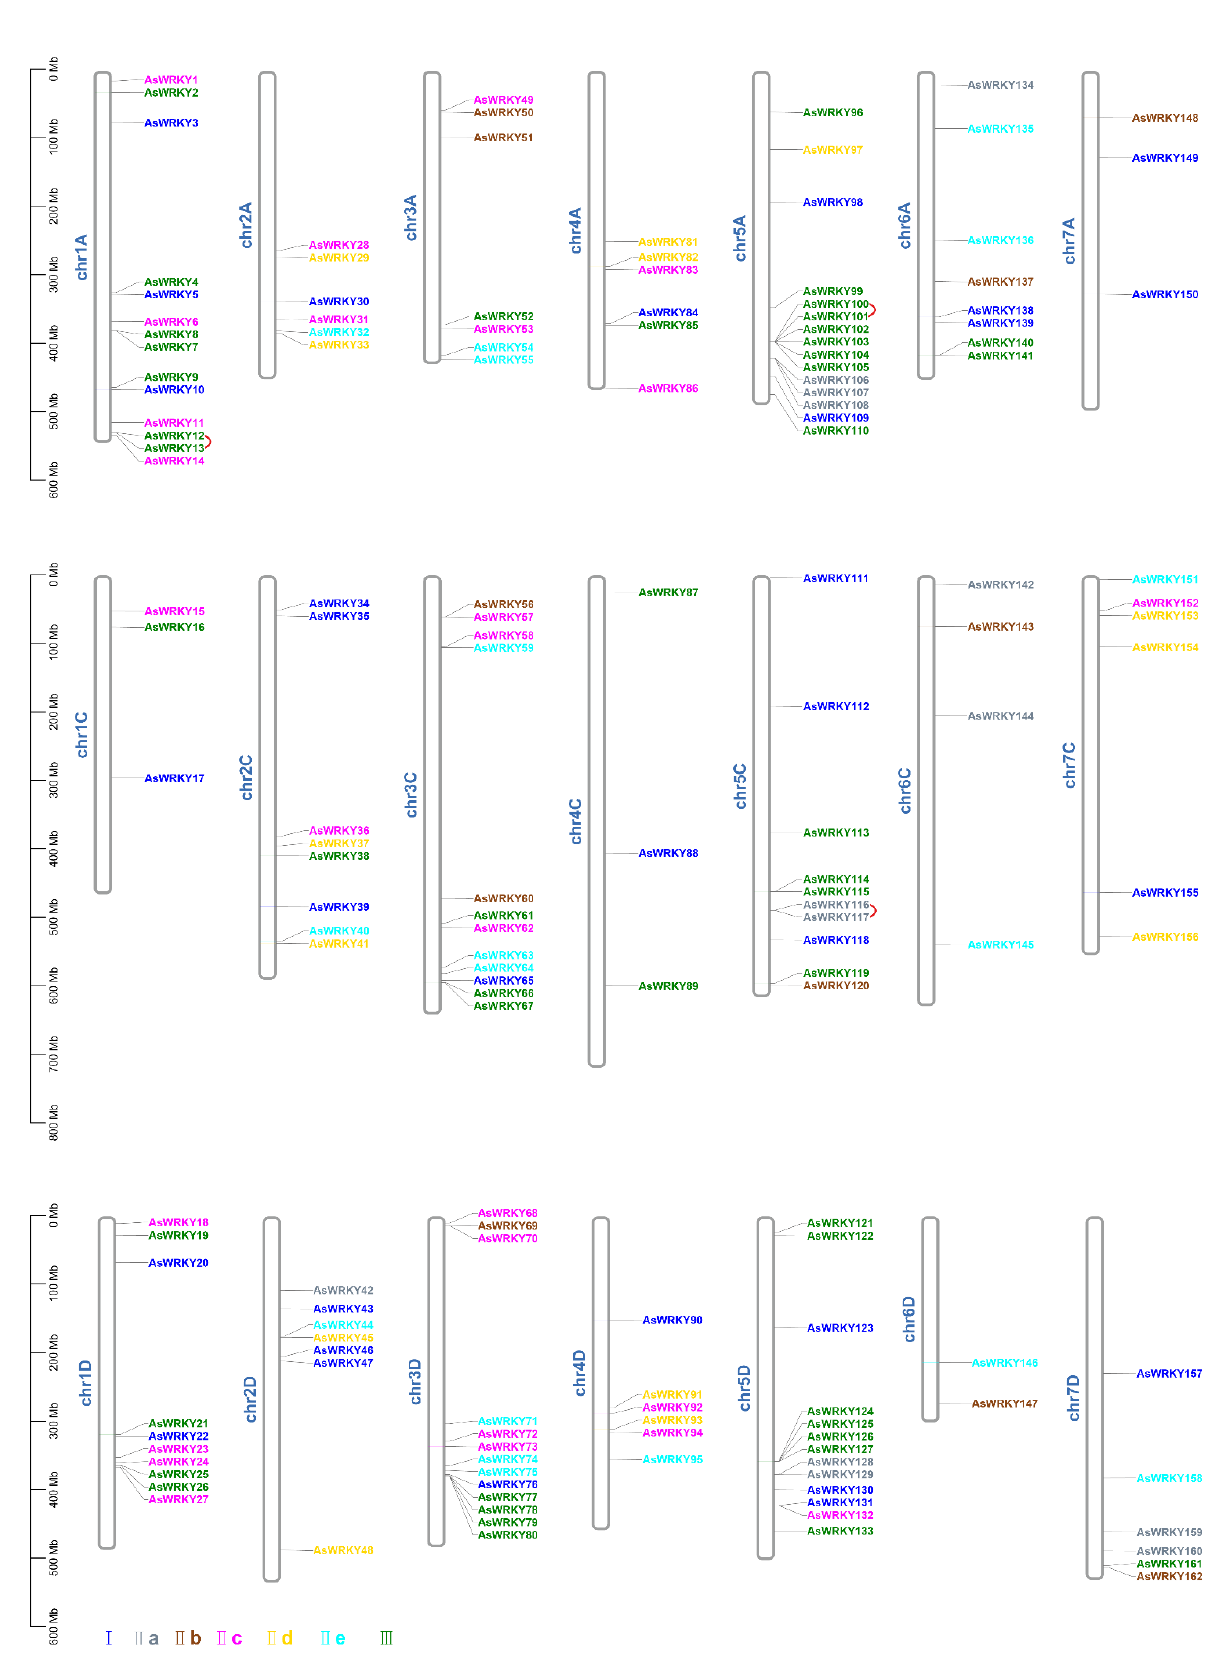
Figure 4. Chromosomal location of AsWRKY genes.